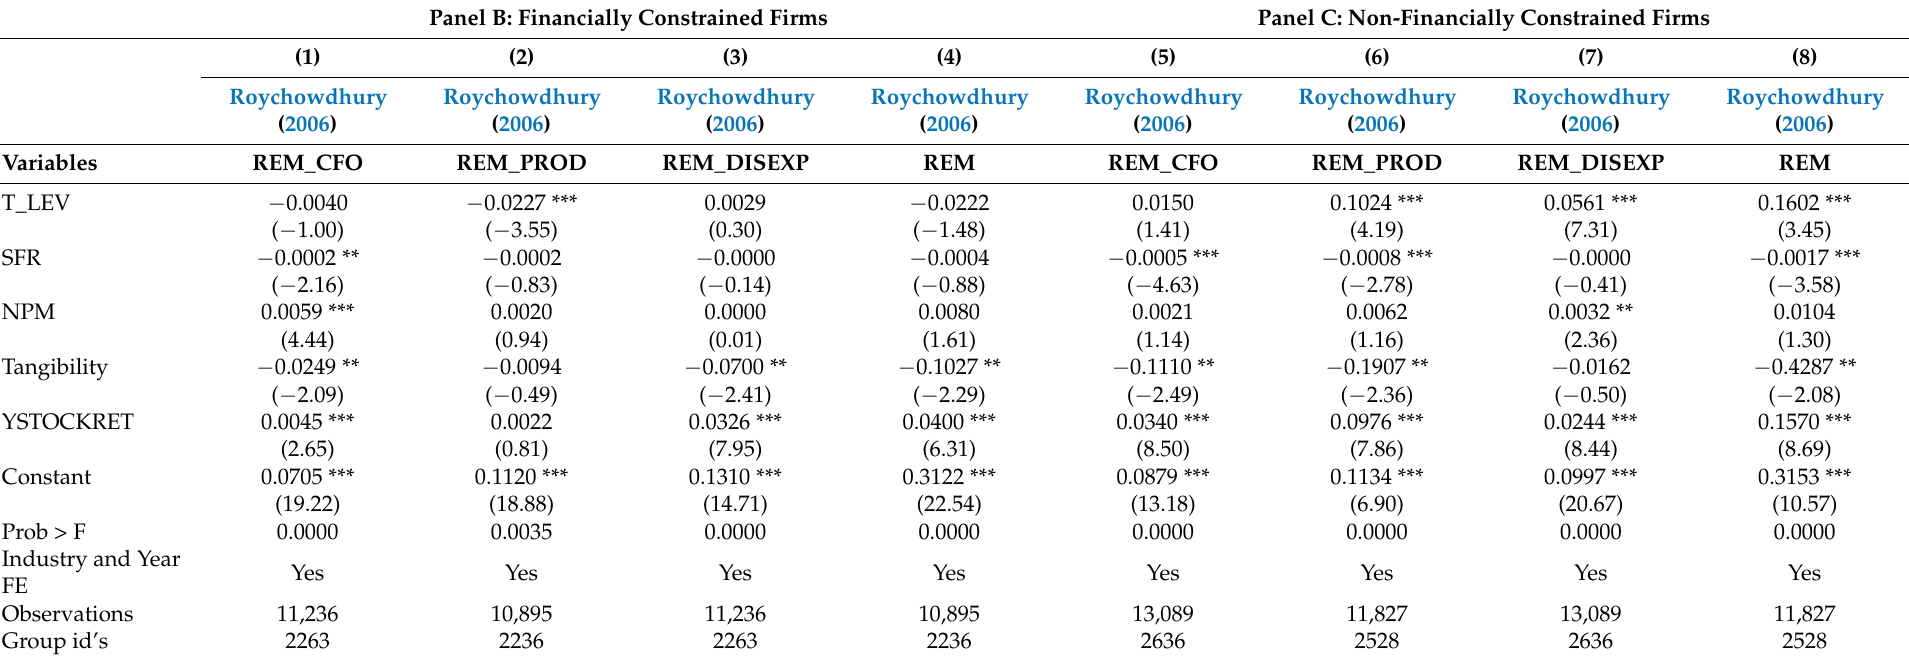
Table 5. H3 estimations (Role of total leverage in determining REM practices in both constrained and unconstrained firms’ scenario). Panel B: Financially Constrained Firms Panel C: Non-Financially Constrained